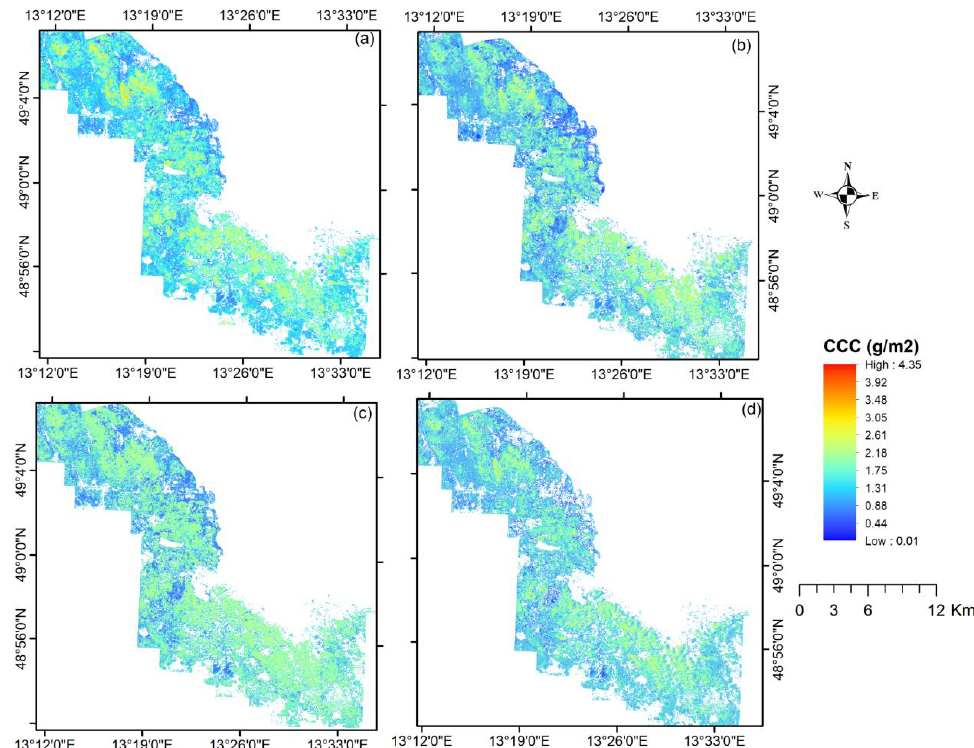
Figure 2. CCC products derived from the Sentinel-2 image acquired on 17 July 2017 over Bavaria Forest National Park by running the SNAP toolbox ( a ), SRVI ( b ), INFORM ( c ), and PLSR ( d ). CCC is higher in deciduous stands than conifers. Remote Sens. 2020 , 12 , 1788